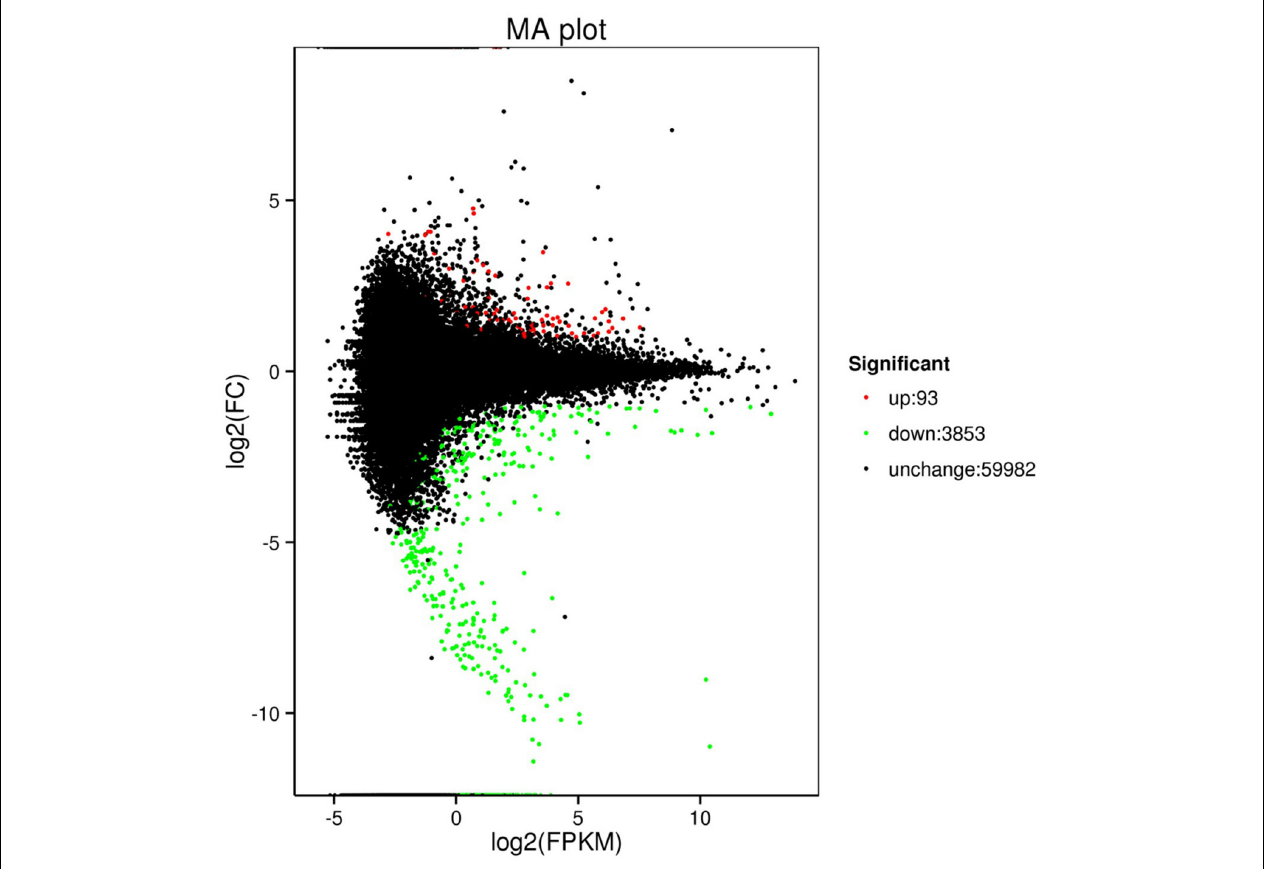
FIGURE 1 | Scatter diagrams representing the comparisons of the genome-wide expression profiles of control and treatment. Note: Each green point represents a decrease in gene expression, each red point represents an increase in gene expression, and each black point represents no significant difference in gene